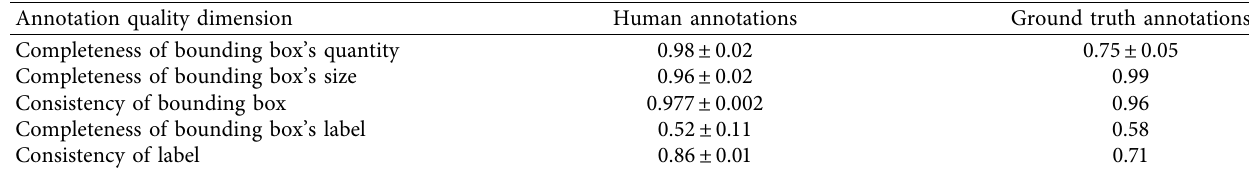
Table 4: Results of other quality dimensions for the downsampled UTS